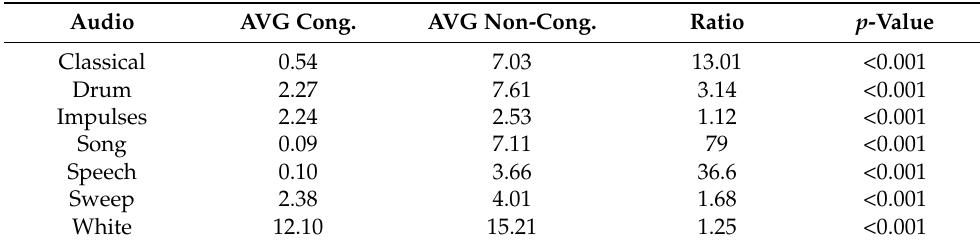
Table 2. AVG Cong. shows the average NED for congruent comparisons; AVG Non-Cong. shows the average NED for non-congruent comparisons; Ratio shows the ratio between congruent AVG and non-congruent AVG; p -value refers to a Welch Two Samples t -test between congruent and non congruent NEDs of the same block.